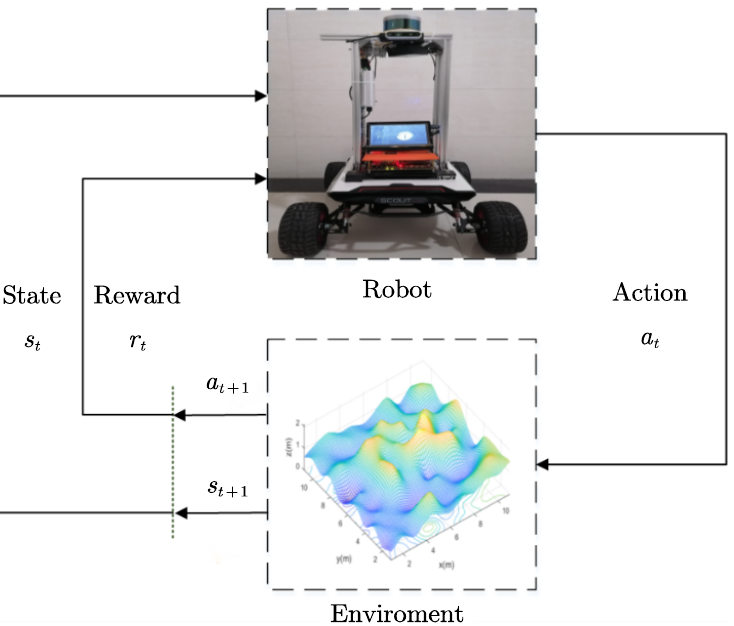
Figure 1. Schematic diagram of interaction between the robot and environment in reinforce- ment